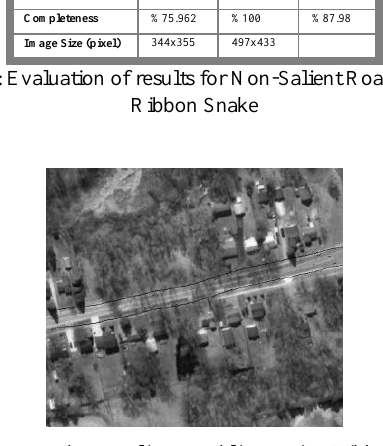
Figure 8: Detected non-salient road lines using Ribbon Snake